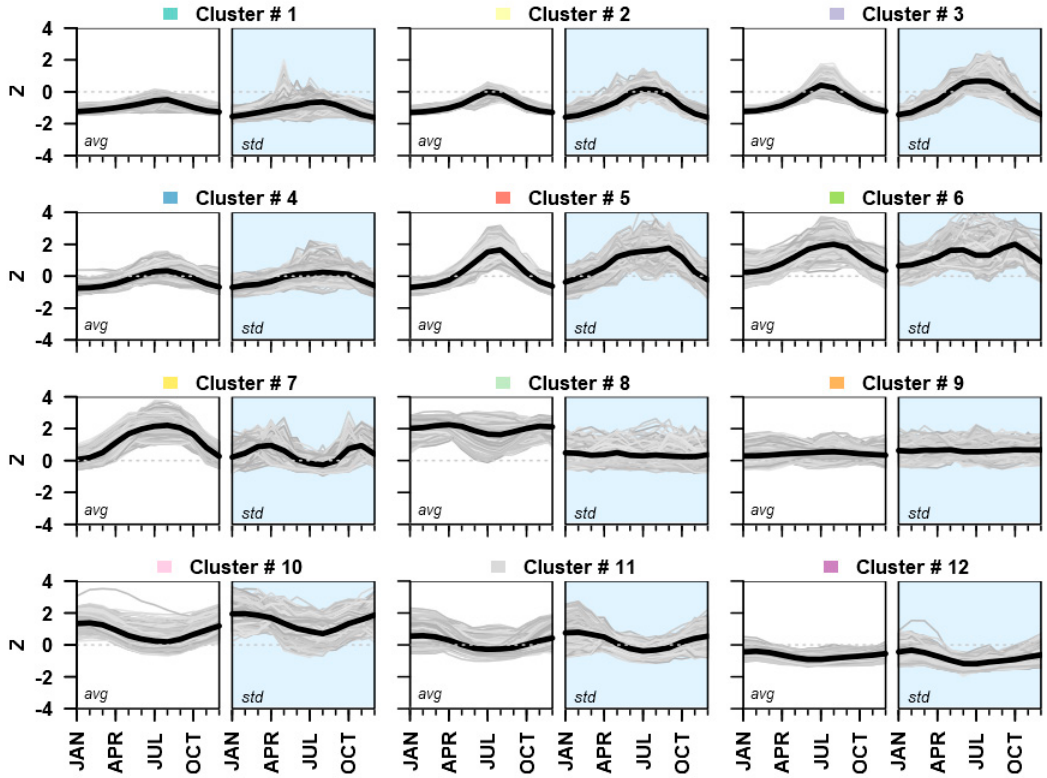
Figure 6. Water vapor seasonality and variability per cluster (Figure 5). The left panel (white background) shows the mean seasonality; the right panel (blue background) shows monthly variability, i.e., standard deviation. The grey curves represent the seasonality and variability of each coordinate in the cluster. The black curve represents the mean seasonality and variability of the cluster. Values were